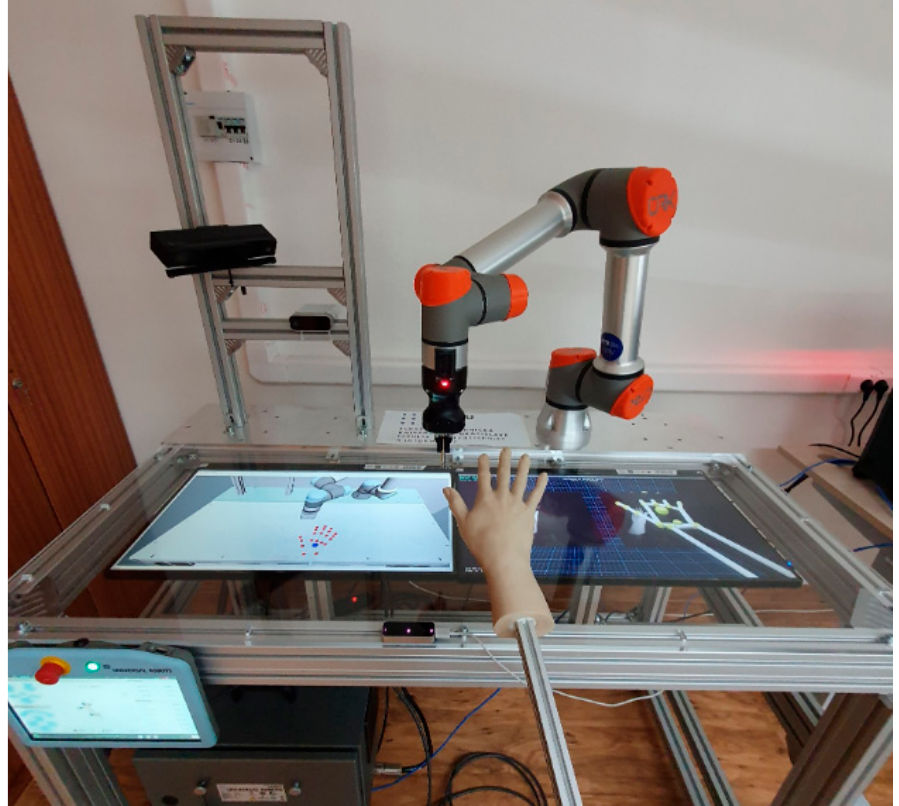
Figure 1. HRI workplace including the Leap Motion Controller.